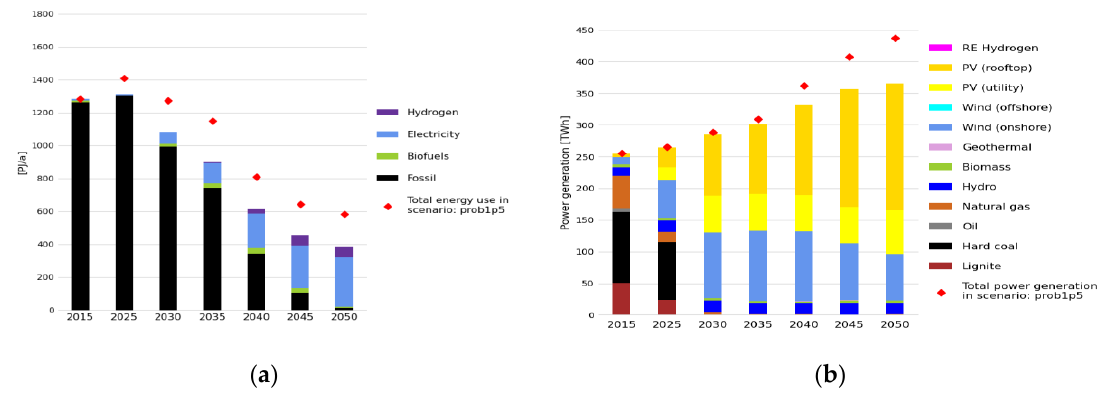
Figure 10. Sensitivity case P1.5 °C-ModalShift versus scenario P1.5 °C: ( a ) Australia’s transport energy use by fuel type over time (including land-based passenger and freight transport); ( b ) development of electricity generation fuel mix over time represented for total Australia (total energy use/produced power in the core scenario P1.5 °C is shown with red markers).